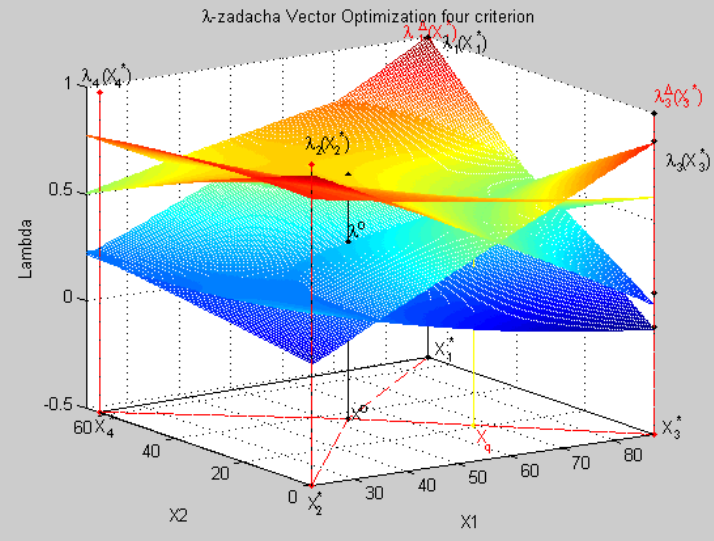
Figure 14. The solution of the λ -problem in a three-dimensional system of coordinates of x 1 , x 2 and λ .